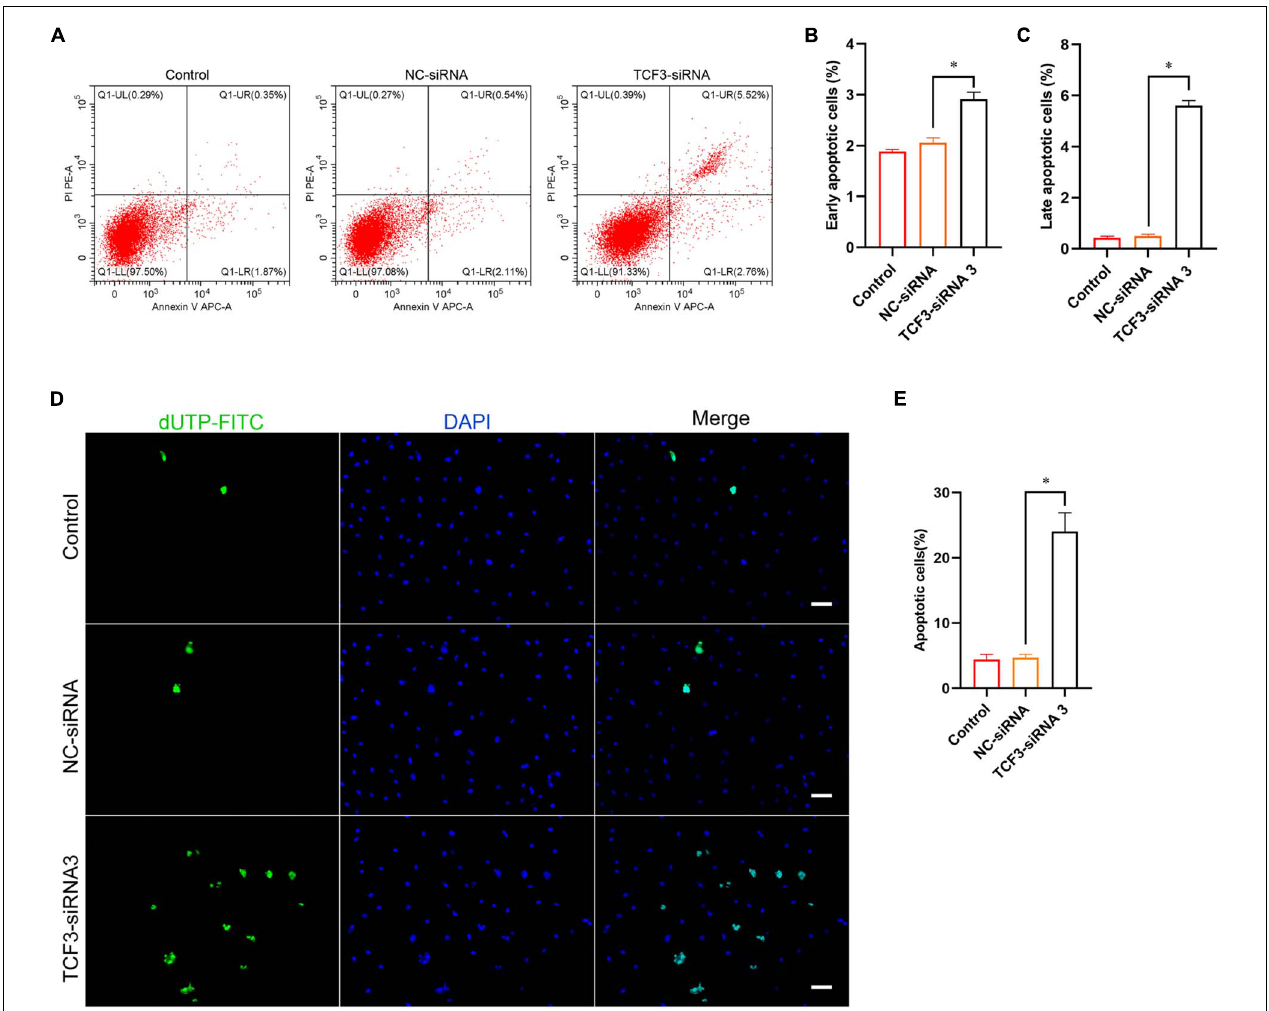
FIGURE 4 | The influence of TCF3 knockdown on the apoptosis of the human SSC cells. (A–C) Flow cytometric and APC Annexin V analysis of the percentages of early and late apoptosis in the human SSC line with transfection of NC-siRNA and TCF3-siRNA 3. (D,E) TUNEL assays of the percentages of TUNEL + cells in the human SSC line with transfection of NC-siRNA and TCF3-siRNA 3. Scale bars: (D) , 50 µ m. ∗ p < 0.05 illustrated the significant differences between TCF3-siRNA 3 and